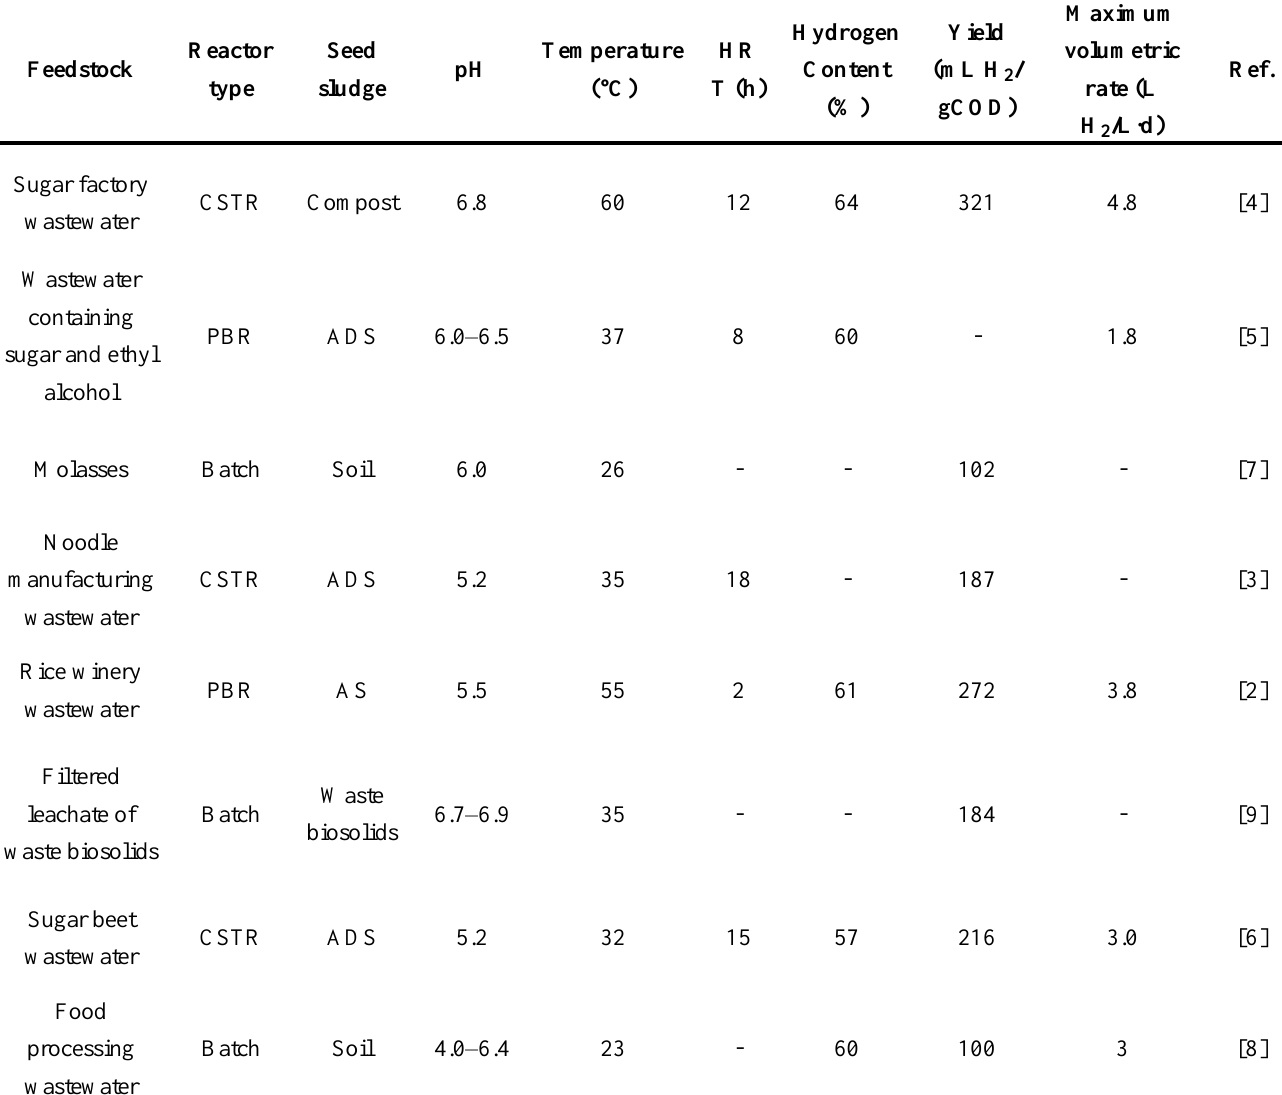
Table 1. Process and performance parameters for actual